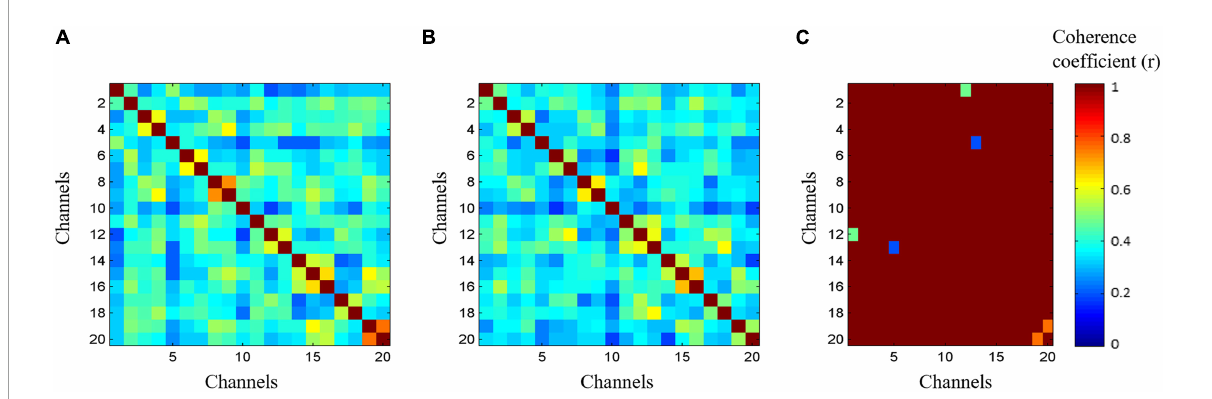
FIGURE6 The resting-state functional connectivity (rsFC) in two groups. Data were extracted from 60 s functional near-infrared spectroscopy (fNIRS) oxy-hemoglobin results after acupuncture. (A) Coherence matrices of acupuncture treatment group. (B) Coherence matrices of sham-acupuncture treatment group. (C) Coherence matrices within the